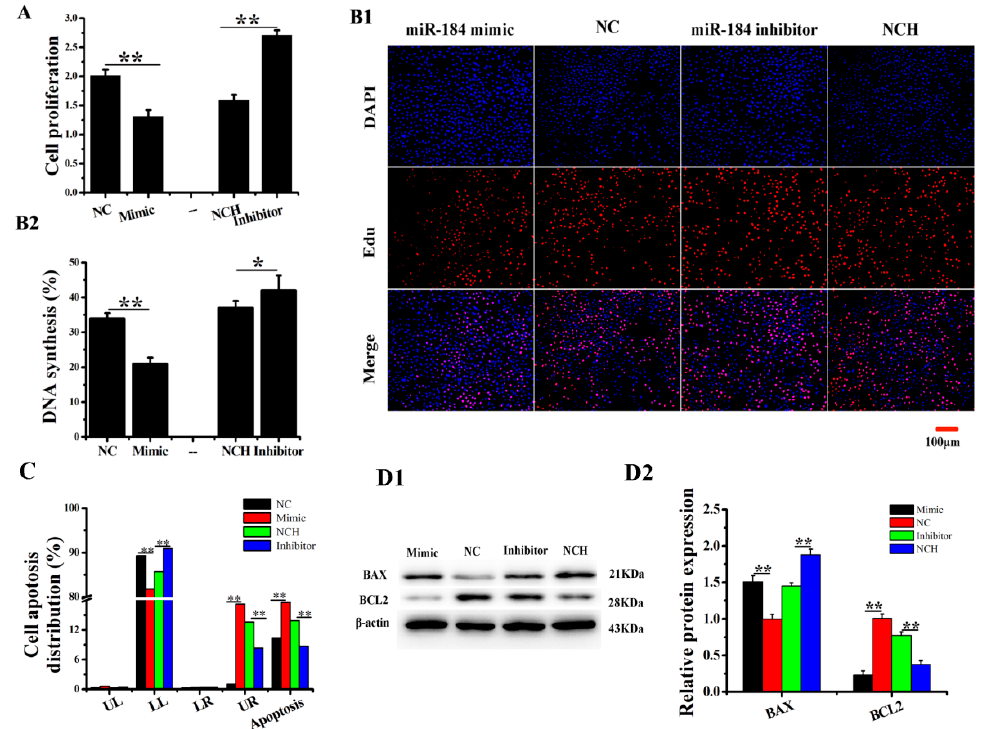
Figure 3. miR-184 promoted EECs apoptosis in vitro. ( A ) CCK-8 was used to detect cell viability. ( B1 , B2 ) Cell proliferation indices were assessed after treatment with EDU. The scale bar is 100 µ m. ( C ) FCM was used to detect apoptosis. ( D1 , D2 ) The WB analysis revealed the expression of